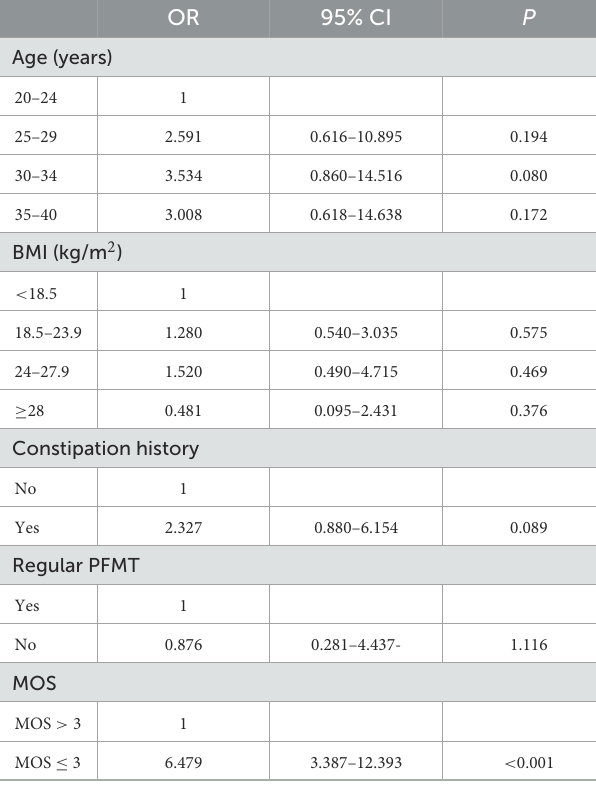
TABLE 2 The sexual function based on PISQ-12 scores for each MOS grade.